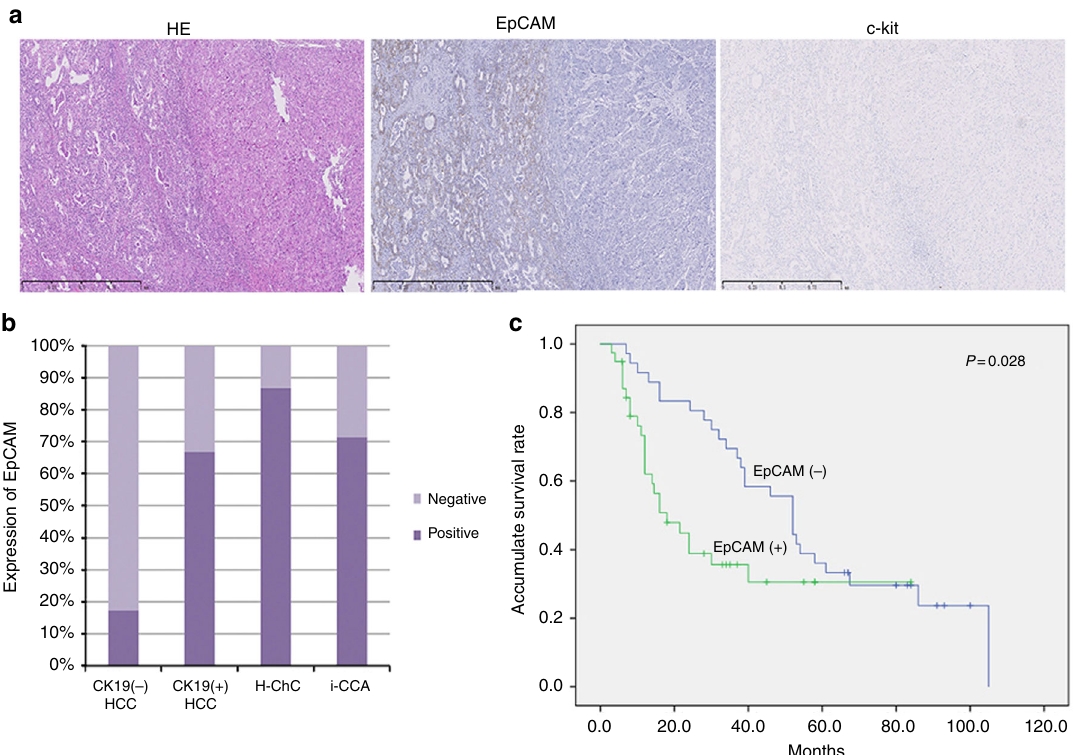
Fig. 6 Expression of stem cell markers and survival analysis. a The tumor cells show immunoreactivity for EpCAM in H-ChC. b The columns show the expression level of EpCAM in H-ChC, HCC, and iCCA. c The survival curve shows the relationship between EpCAM expression and suivival. The scale bar represents 1